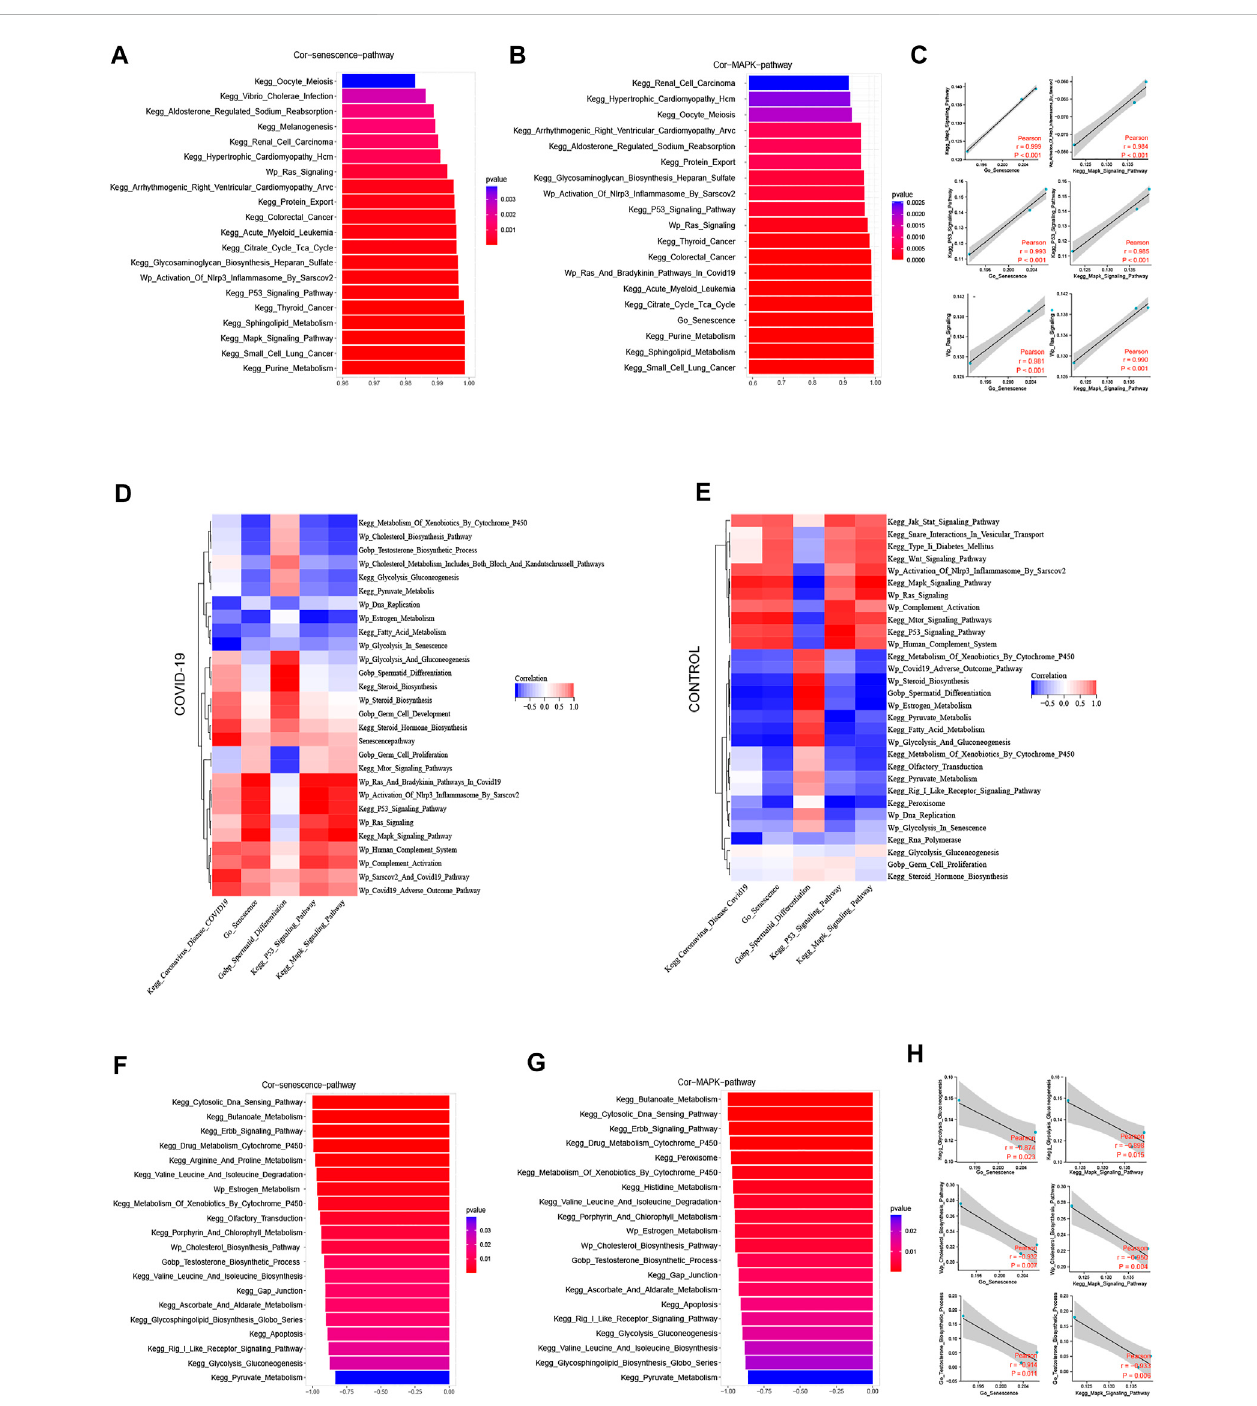
FIGURE 3 Screening pathways associated with cellular senescence during COVID-19 infection. (A) The top 20 pathways in COVID-19 were signi fi cantly positively correlated with cellular senescence, among which MAPK signaling pathway was the most relevant ( r = .999, p < .001). (B) The top 20 pathways that were signi fi cantlypositivelycorrelatedwithMAPKsignalingpathwaysaresimilartothoserelatedtocellularsenescence. (C) CellularsenescenceandMAPKsignaling pathways are roughly consistent with cell cycle-related pathways. (D) The correlation of cellular senescence with GO gene sets, KEGG pathways, and WIKIPATHWAYS pathways in COVID-19 group. (E) The correlation of cellular senescence with GO gene sets. KEGG pathways, and WIKIPATHWAYS pathways in the Control group. (F) The top 20 pathways in COVID-19 were negatively correlated with cellular senescence ( r < − .8, p < .001). These pathways mainly function in cholesterol and testosterone synthesis, as well as glycolysis and pyruvate metabolism. (G) COVID-19 were signi fi cantly negatively correlated with MAPK signaling pathway ( r < − .8, p < .001), and their main enrichment pathways were similar to those related to cellular senescence (H) Cellular senescence and MAPK signaling pathway were roughly consistent with testosterone synthesis, cholesterol synthesis and glycolysis